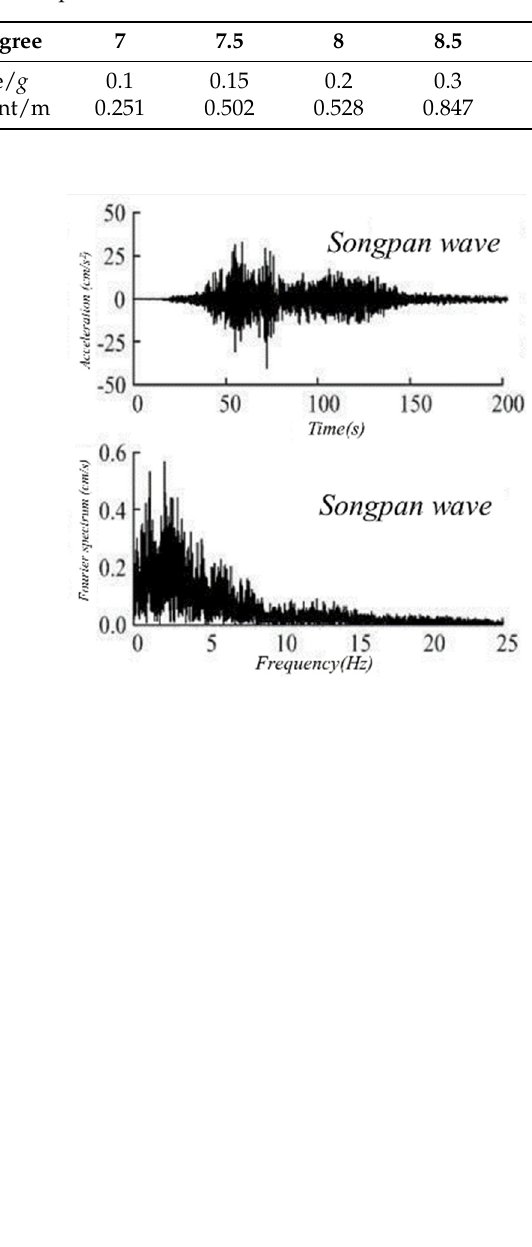
Table 1. Maximum free-field horizontal displacement.